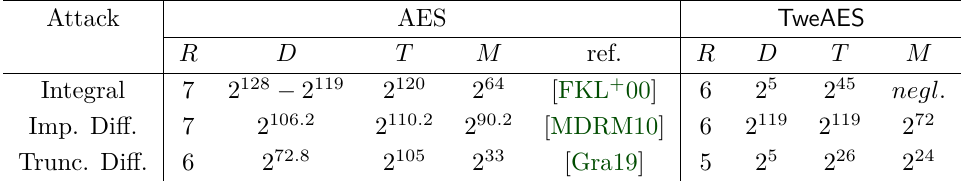
Table 2: Comparison of the attacks on AES and TweAES exploiting tweak in Sect. 3.4.2. R , D , T and M denote the number of rounds, data complexity, time complexity and memory complexity,